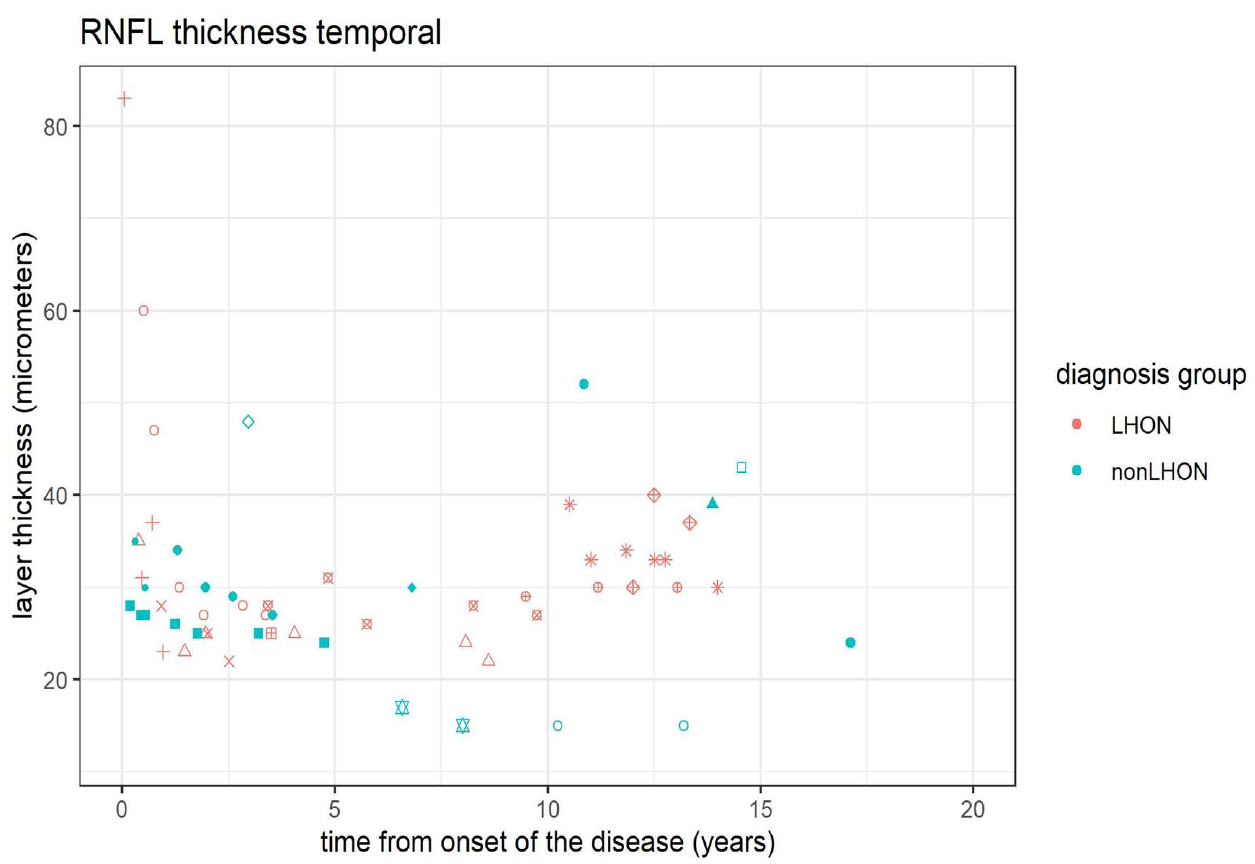
Figure 7. Longitudinal analysis of the pRNFL trend in LHON and nonLHON group shows a trend of thickening of the temporal field pRNFL in the LHON group. Different symbols refer to a particular patient, symbols in red belong to the LHON patients, whilst nonLHON patients are marked with green symbols. Note tendency of thickening in the temporal field in LHON group.